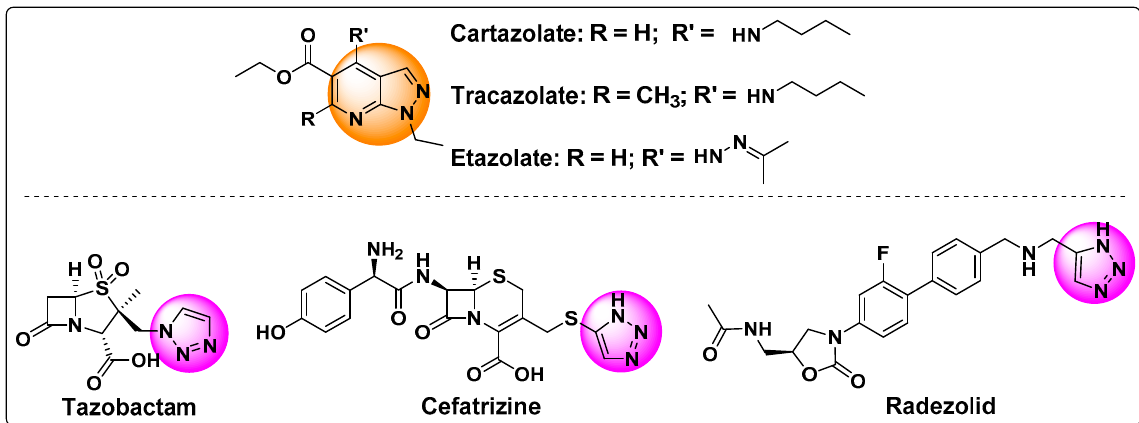
Figure 1. Structures of important pyrazolo[3,4- b ]pyridine and triazole antibacterial agents.